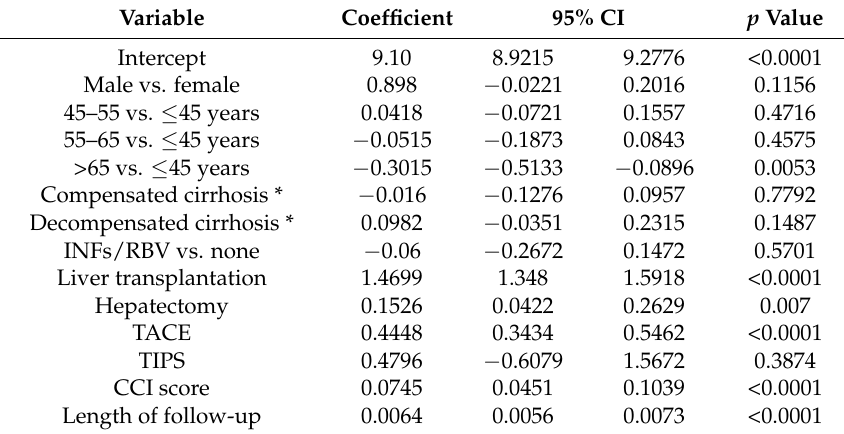
Table 5. Factors associated total lifetime cost per